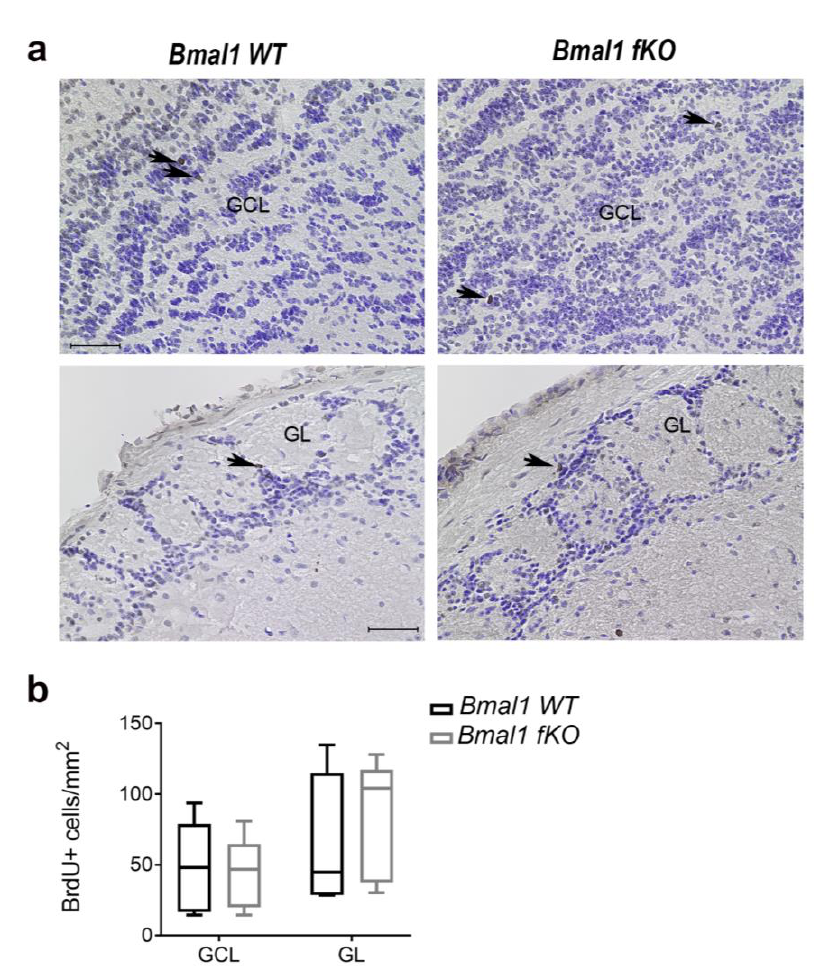
Figure 7. Proliferating cells in the olfactory bulb of Bmal1 fKO mice. ( a ) Representative photomicrographs of BrdU + cells (brown, arrows) and cresyl violet staining (blue) in the granule cell layer (GCL) and the glomerular layer (GL) of the olfactory bulb. Scale bars = 50 µ m. ( b ) The number of BrdU + cells in the GL and the GL of the olfactory bulb was not di ff erent between Bmal1 WT and Bmal1 fKO mice. n = 5 mice per genotype.